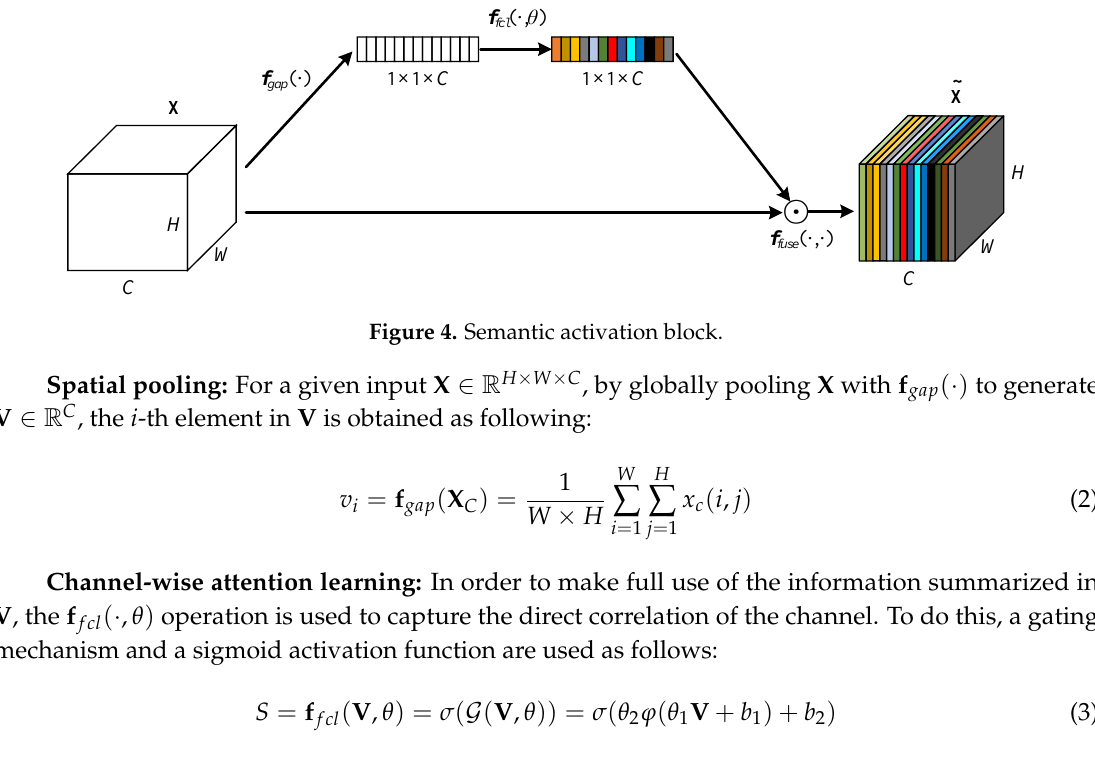
Figure 4 Semantic activation block